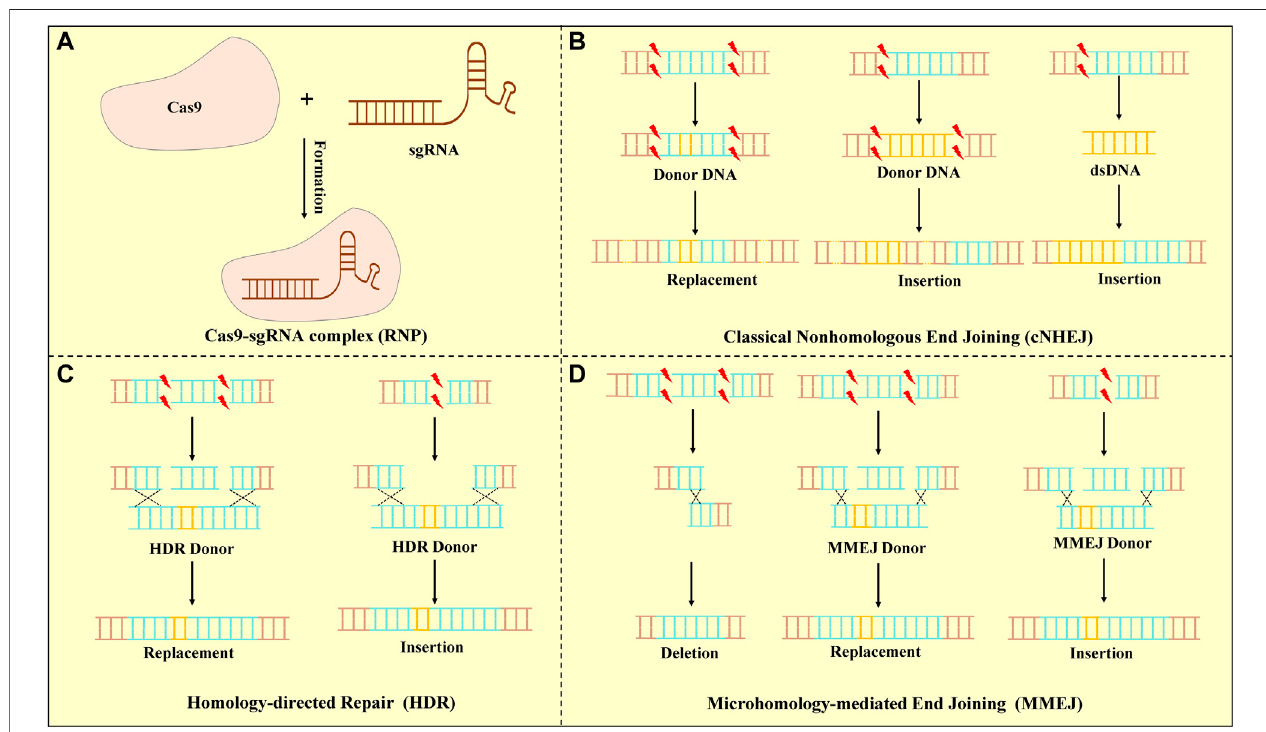
FIGURE 1 | CRISPR/Cas9 system and DSB repair. (A) Mechanism of the CRISPR-Cas9 system. A short guide sgRNA associates with the Cas9 endonuclease to formtheCas9-sgRNA complex.Cas9isatargeted DNAbyPAMunderthesgRNA. (B) cNHEJ :cNHEJ wasthepredominantpathway forrepairingDSBsandwasused for re-ligating broken DNA ends. Deletions or insertion mutations lead to gene frame shift mutations or premature generation of stop codes. (C) HDR: HDR was used a homologous DNA template toguide DSB repair. The DNA donor templates of HDR were used to insert or replace speci fi csequences into thegenome. (D) MMEJ: MMEJ-mediated repair was capable of generating precise deletions between two short micro-homologous sequences (5 – 25 base pairs) at target